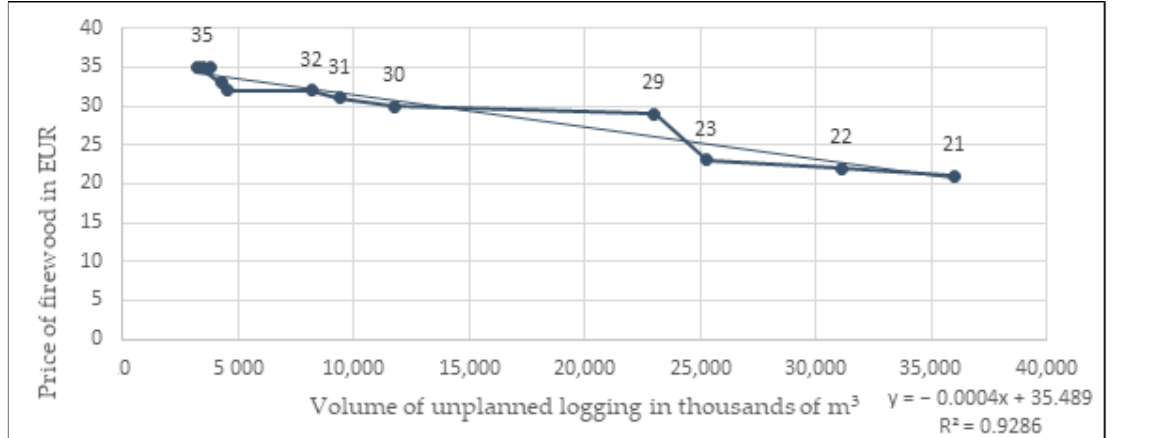
Figure 4. Dependence of the price of firewood on the volume of unplanned logging; Source: Č SU, (Czech Statistical Agency) 2020, Forestry.